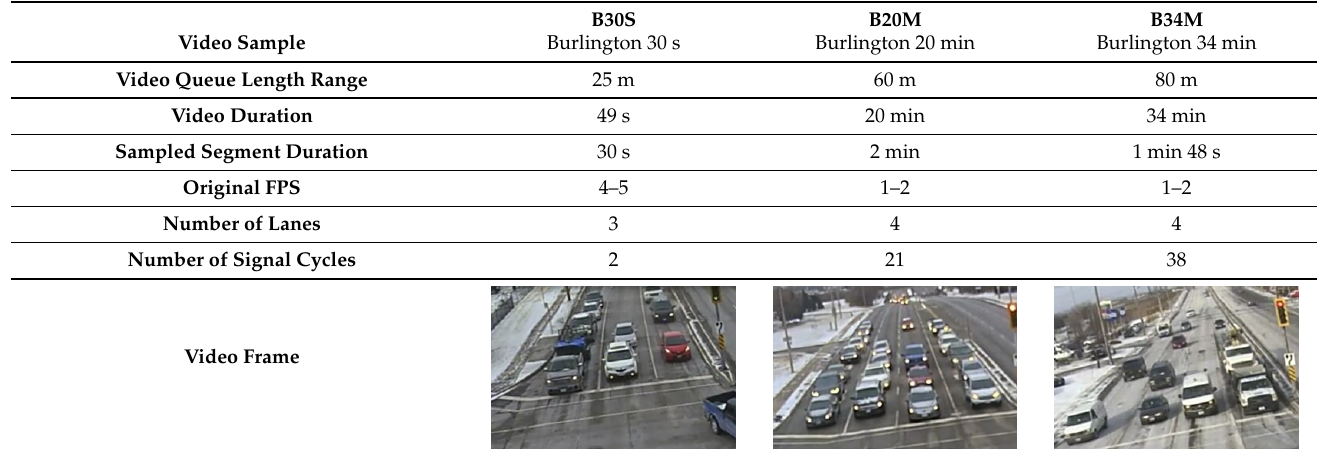
Figure 5. Queue length calculation. Table 1. Burlington video